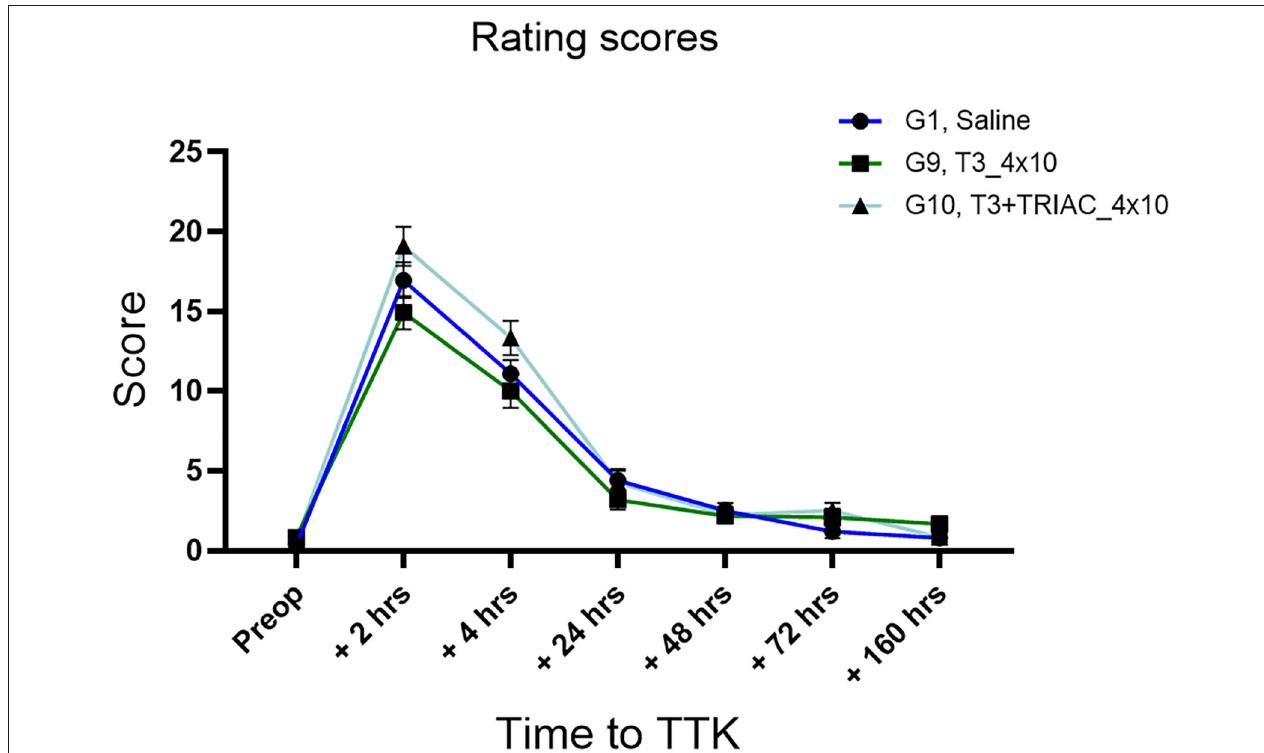
FIGURE 5 | Semi-quantitative assessment of the T3 treatment on vertigo syndrome in vestibular defective rats. T3 treatment shows no significant effect on the considered parameters (Two-way ANOVA, NS). n =